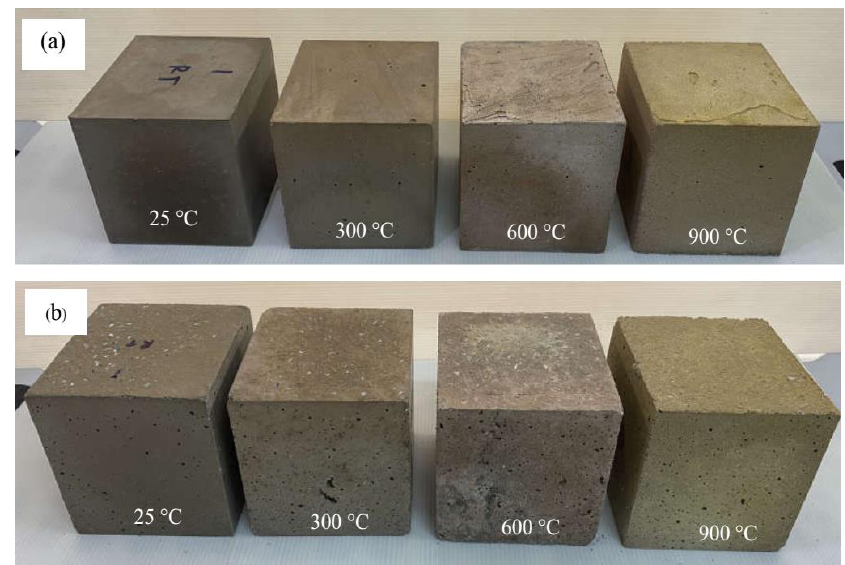
Figure 15. Specimens after exposure to elevated temperatures ( a ) LG00 ( b ) LG10.